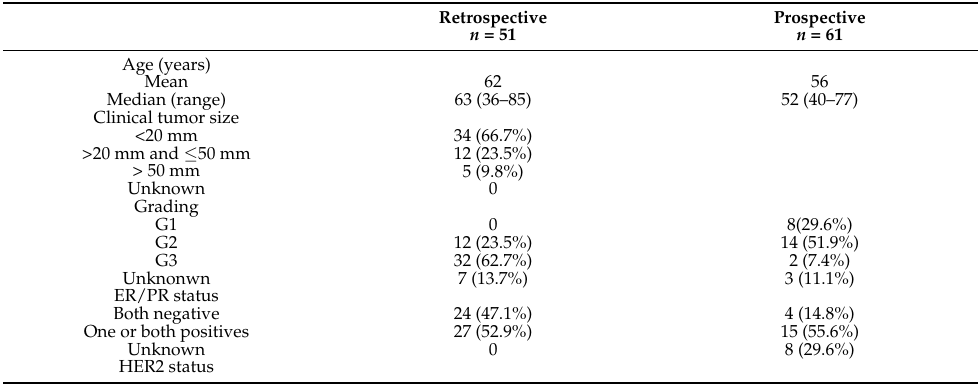
Table 1. Patient clinical